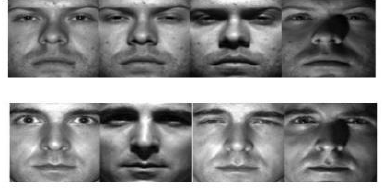
Figure 4. YaleB dataset.